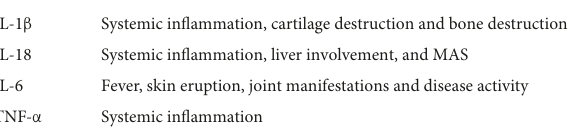
TABLE 1 Cytokine profile and targeting